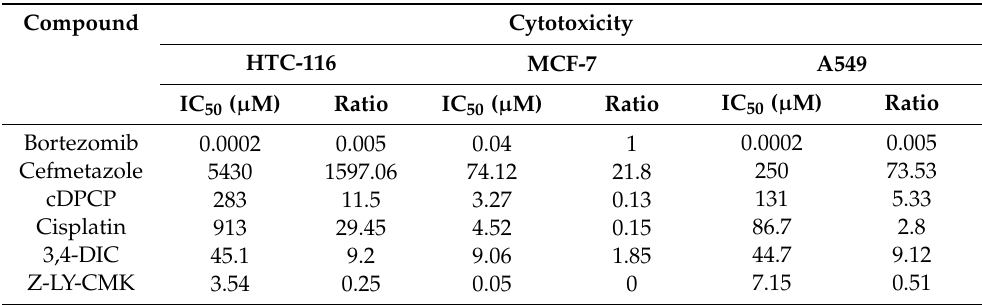
Table 2. Cytotoxicity potential of ClpP inhibitors against the human cell lines HTC-116, MCF-7, and A549 as quantified by a luminescent cell viability assay (IC 50 ). The ratio compares the results with ClpP inhibition as shown in Table 1 (IC 50 cytotoxicity/IC 50 ClpP). Compound